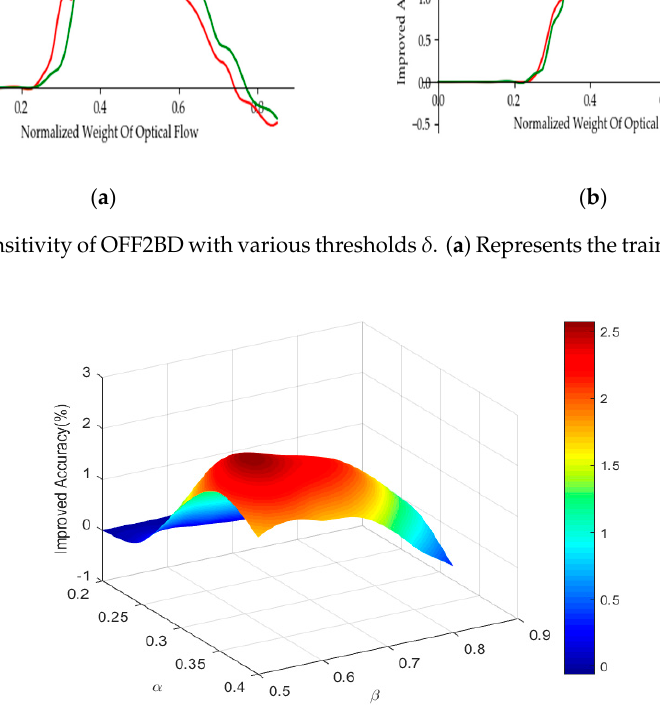
Figure 5. The sensitivity of OFF3WD with various thresholds ( α , β ) .